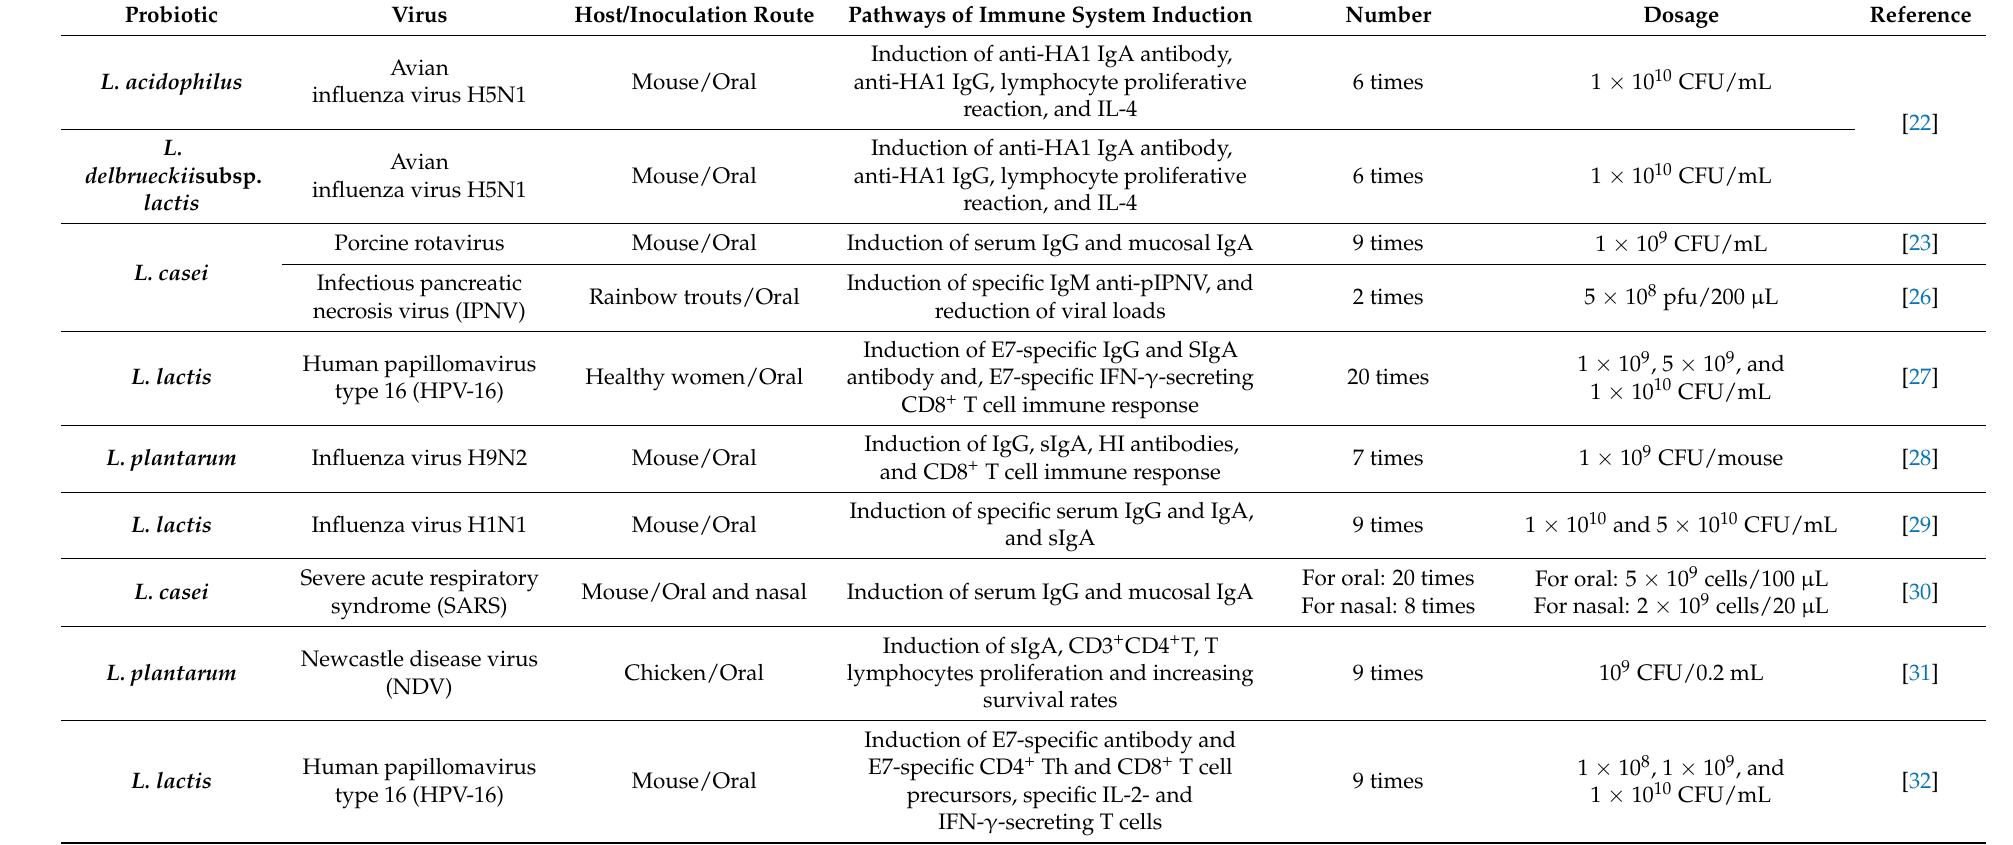
Table 1. Pre-clinical and clinical studies of probiotic-based vaccines against respiratory and non-respiratory